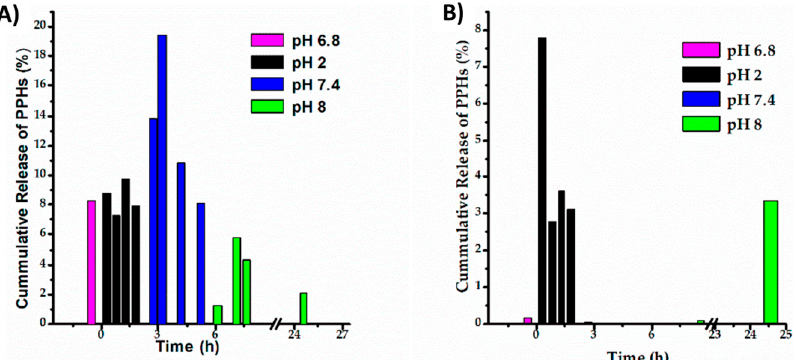
Figure 3. Cumulative release of phenolic compounds present in Oregano ( Lippia graveolens ) and encapsulated in chitosan- b -PPEGMA ( A ) and single chitosan ( B ) matrices. The trials were performed in simulated salivary fluids. The figure was taken from the literature [55].